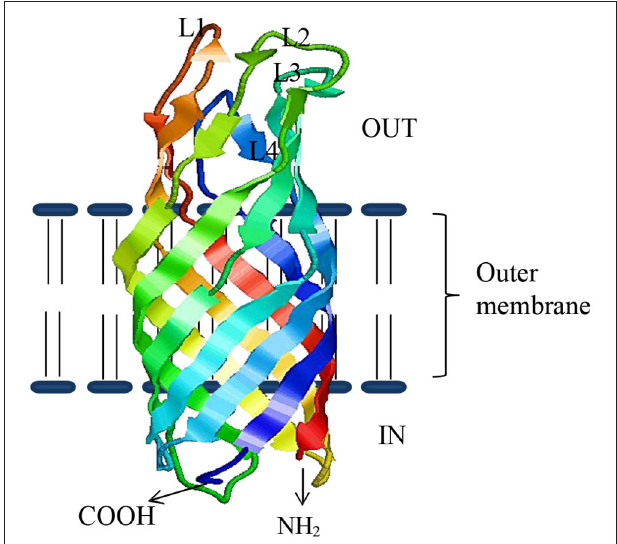
FIGURE 1 | The β -sheeted architecture of OmpW protein of A. hydrophila . Four outside exposed loops of the protein are indicated as L1–L4, respectively.